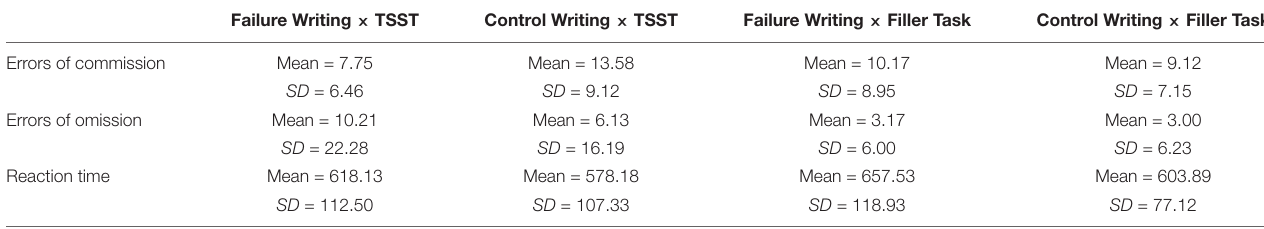
TABLE 5 | SART performance across stress and writing group. Failure Writing × TSST Control Writing × TSST Failure Writing × Filler